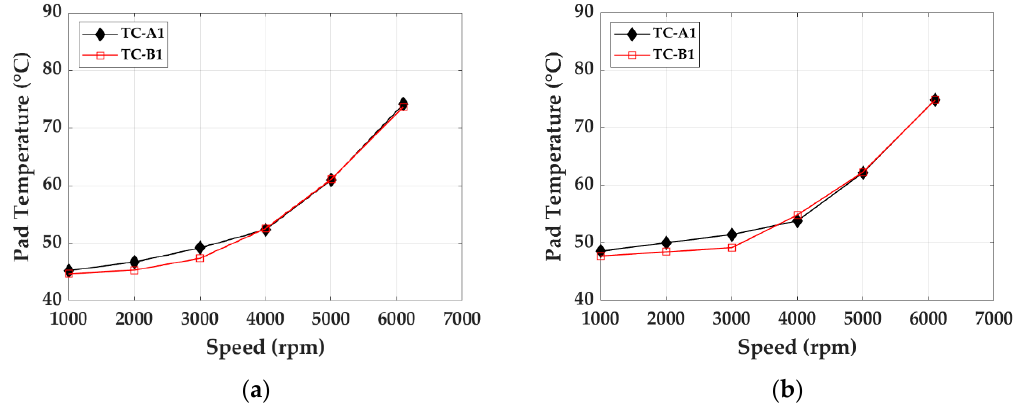
Figure 21. Flooded Ball & Socket Pivot bearing pad temperatures @ 25% of pad arc: ( a ) 1.0 MPa, ( b ) 1.7 MPa.